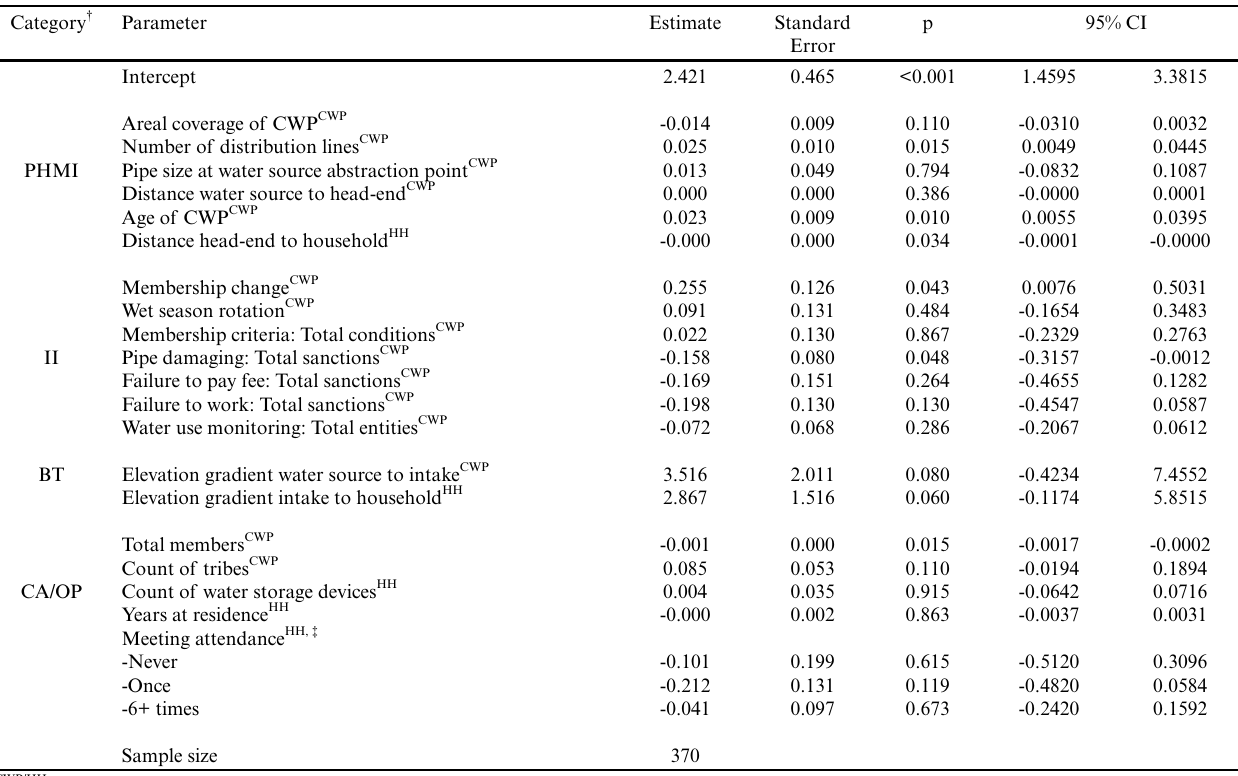
Table 7. Multilevel model results: average household flow